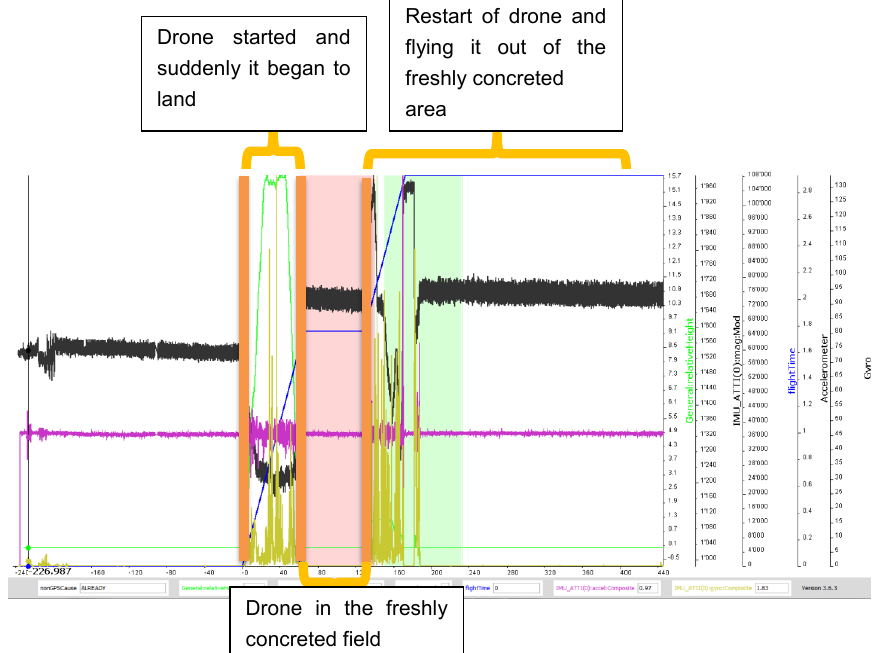
Figure 69: Flight data visualization of measurement 3 Figure 10. Magnetic field